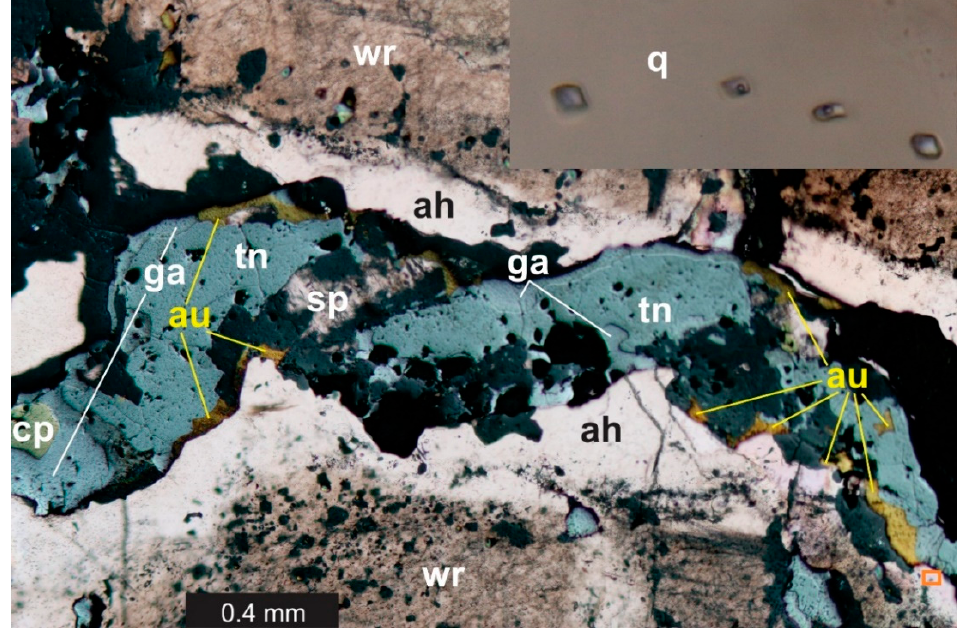
Figure 4. Composite photomicrographs of the alteration halo surrounding the gold-bearing veinlets and fluid inclusions. The main image, taken under simultaneous plane-polarized transmitted and reflected light, shows the barite-rich wall rock (wr) and quartz dominated alteration halo (ah) surrounding the veinlet. The veinlet assemblage comprises tennantite (tn), galena (ga), sphalerite (sp), chalcopyrite (cp), and gold/electrum (au). The inset image shows the magnified region delineated by the orange rectangle, in plane-polarized light, comprising a trail of “boiling” pseudosecondary two-phase (liquid + vapor) fluid inclusions hosted within a quartz (q) crystal lining the walls of the veinlet. The two central fluid inclusions from population P1L represent the liquid portion of the boiling fluid, while the two outer fluid inclusions are from population P1V and represent the conjugate vapor inclusions of the boiling system. Sample RG14-21B, inset field of view is approximately 50 microns wide.